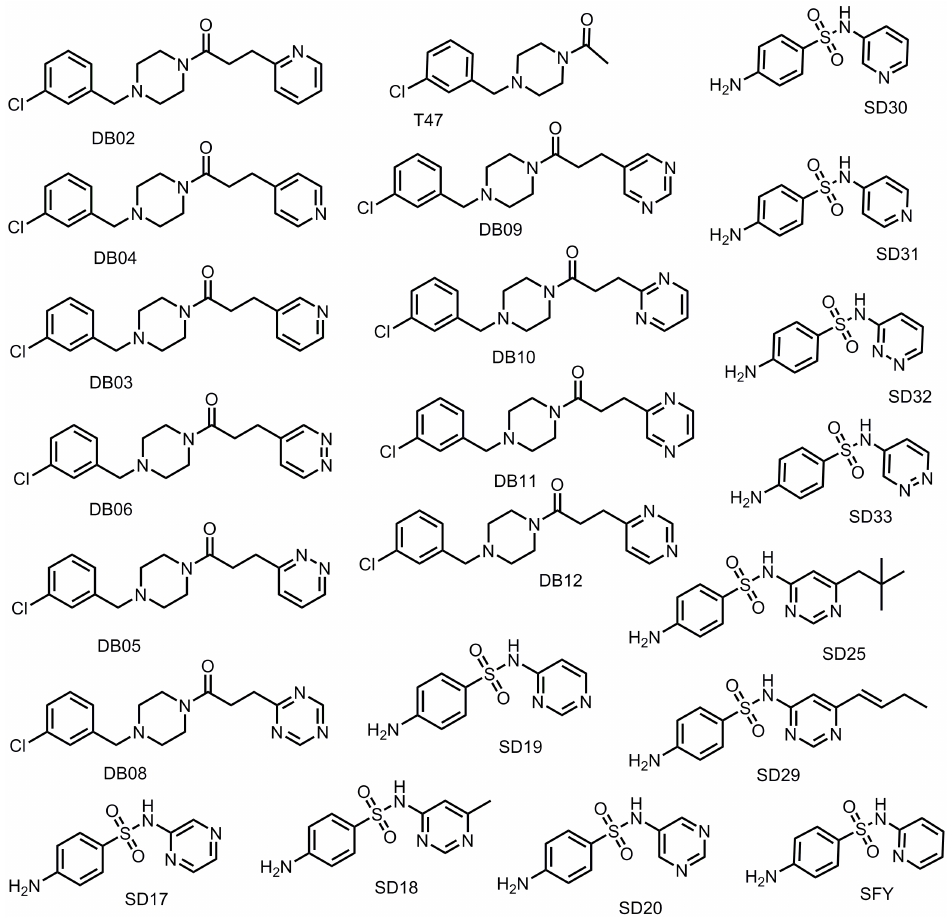
Figure 9. Structures of T47 and SFY compound derivatives designed for nitrogen heterocycle